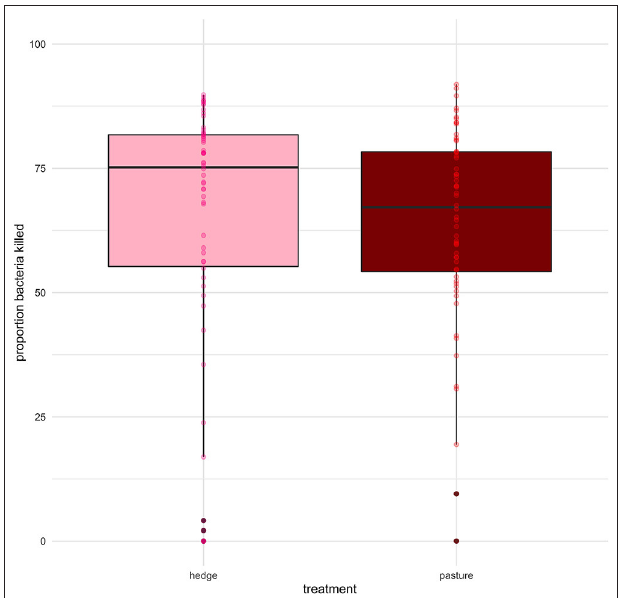
FIGURE 6 | Effect of treatment (hedge access) on bacterial killing ability (BKA) of Red rangers. Red rangers raised with a hedgerow show greater immune function compared to Red rangers raised in bare pasture. Hedge access had no significant effect on Cornish cross BKA. LMEM proportion E. coli killed (1:200) ∼ treatment + week + sex + (1|Block:Pop:ID).